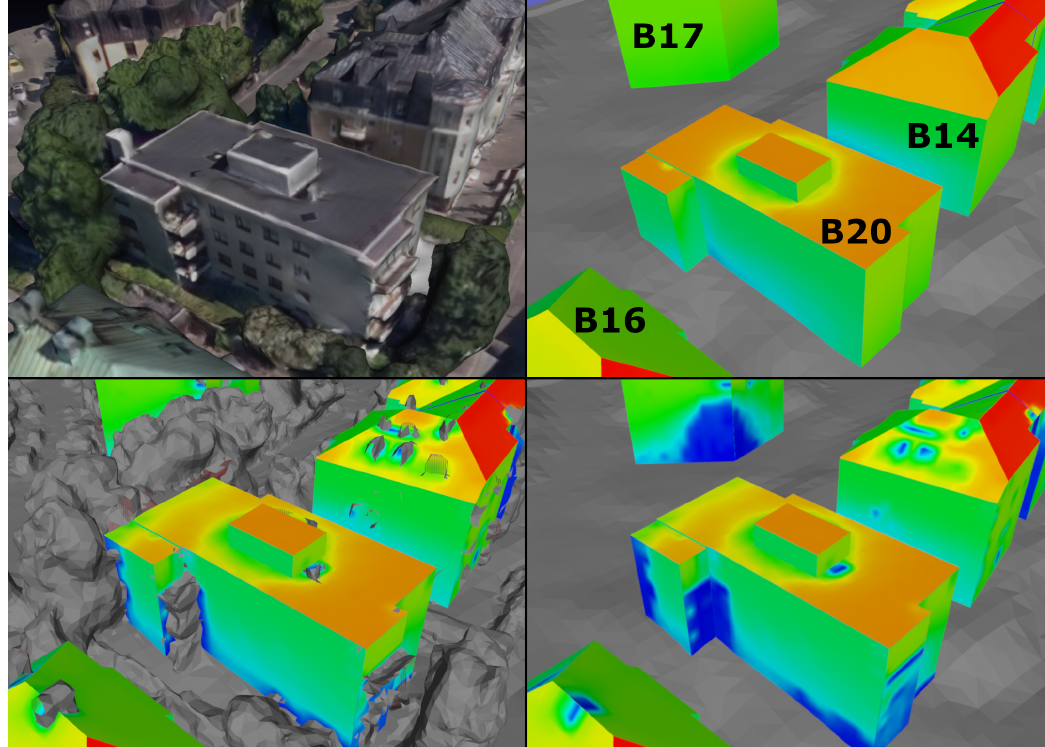
Figure 10. Sample buildings from the case study. Top left: Textured mesh model. The other images show the semantic model with solar potential analysis result textures (blue to red → low to high irradiation). Top right: Results without mesh integration and building numbers. Bottom left: Results with mesh integration, mesh is displayed. Bottom right: Results with mesh integration, mesh is faded